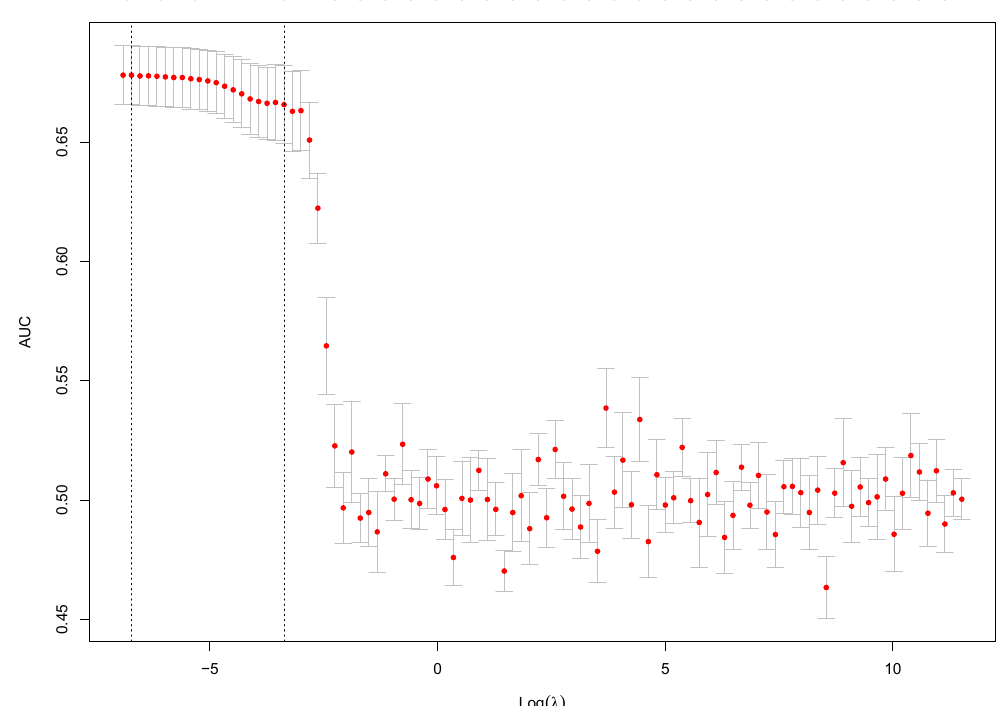
Figure 3. Using the training set, AUC values and its 95% confidence intervals for different logarithmic values of λ represented on x -axis, where λ is the regularization parameter in the model. Vertical lines correspond to Log( λ min ) and Log( λ se ) which are the most optimal Log( λ ) values.